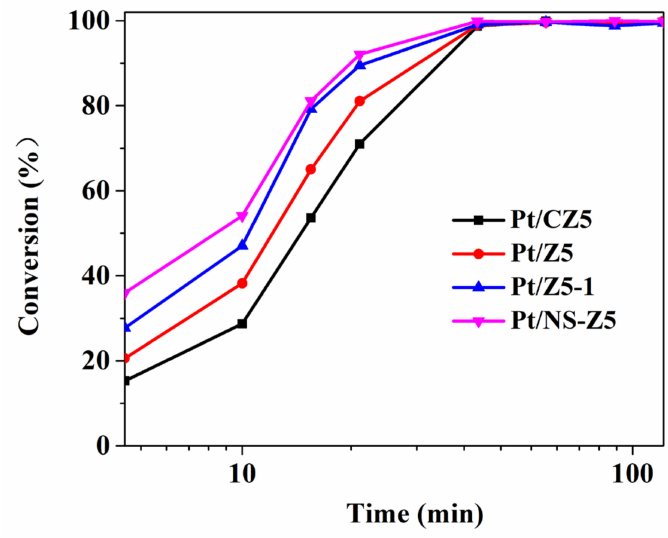
Figure 8. Time-dependent guaiacol conversions obtained for di ff erent Pt-loaded zeolite